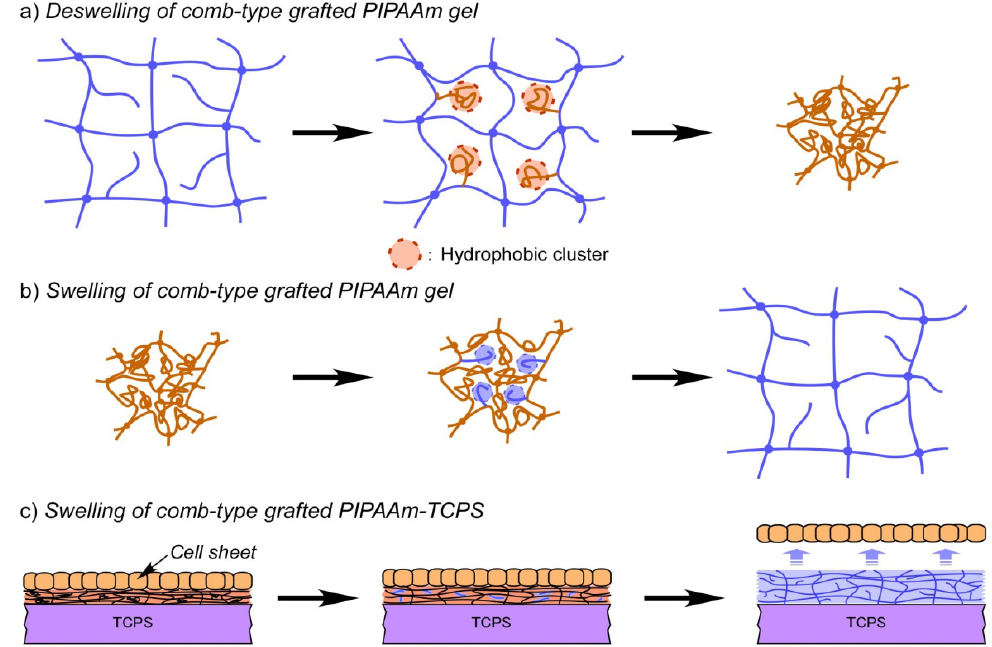
Figure 6. Schematic drawing of ( a ) de-swelling; ( b ) swelling of comb-type grafted PIPAAm gel and ( c ) the swelling of comb-type grafted PIPAAm gel modified surface.